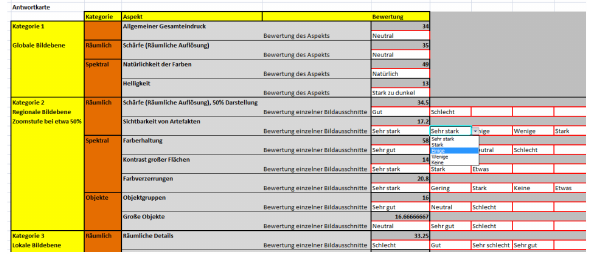
Figure 7. External answer sheet (German version) (Fries 2017)